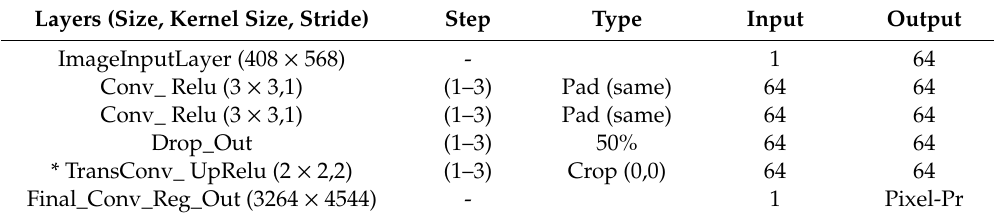
Figure 7. Schematic diagram of the up-sampling network. Table 2. The detailed structure of the distortion correction network.